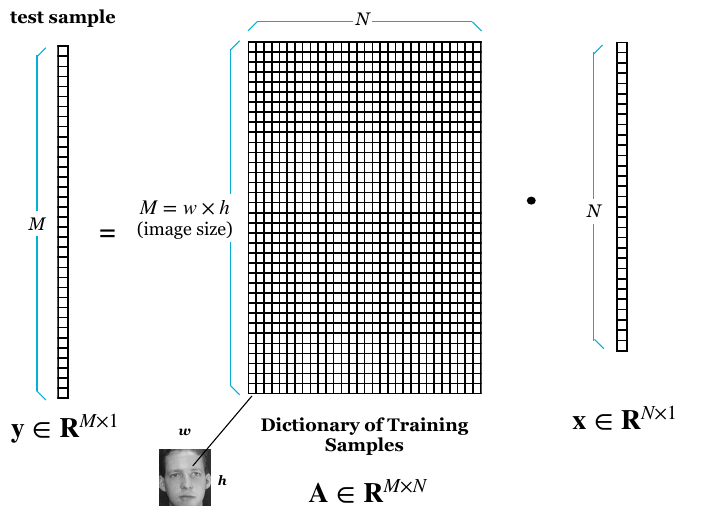
Figure 1. SRC before Dimensionality Reduction.